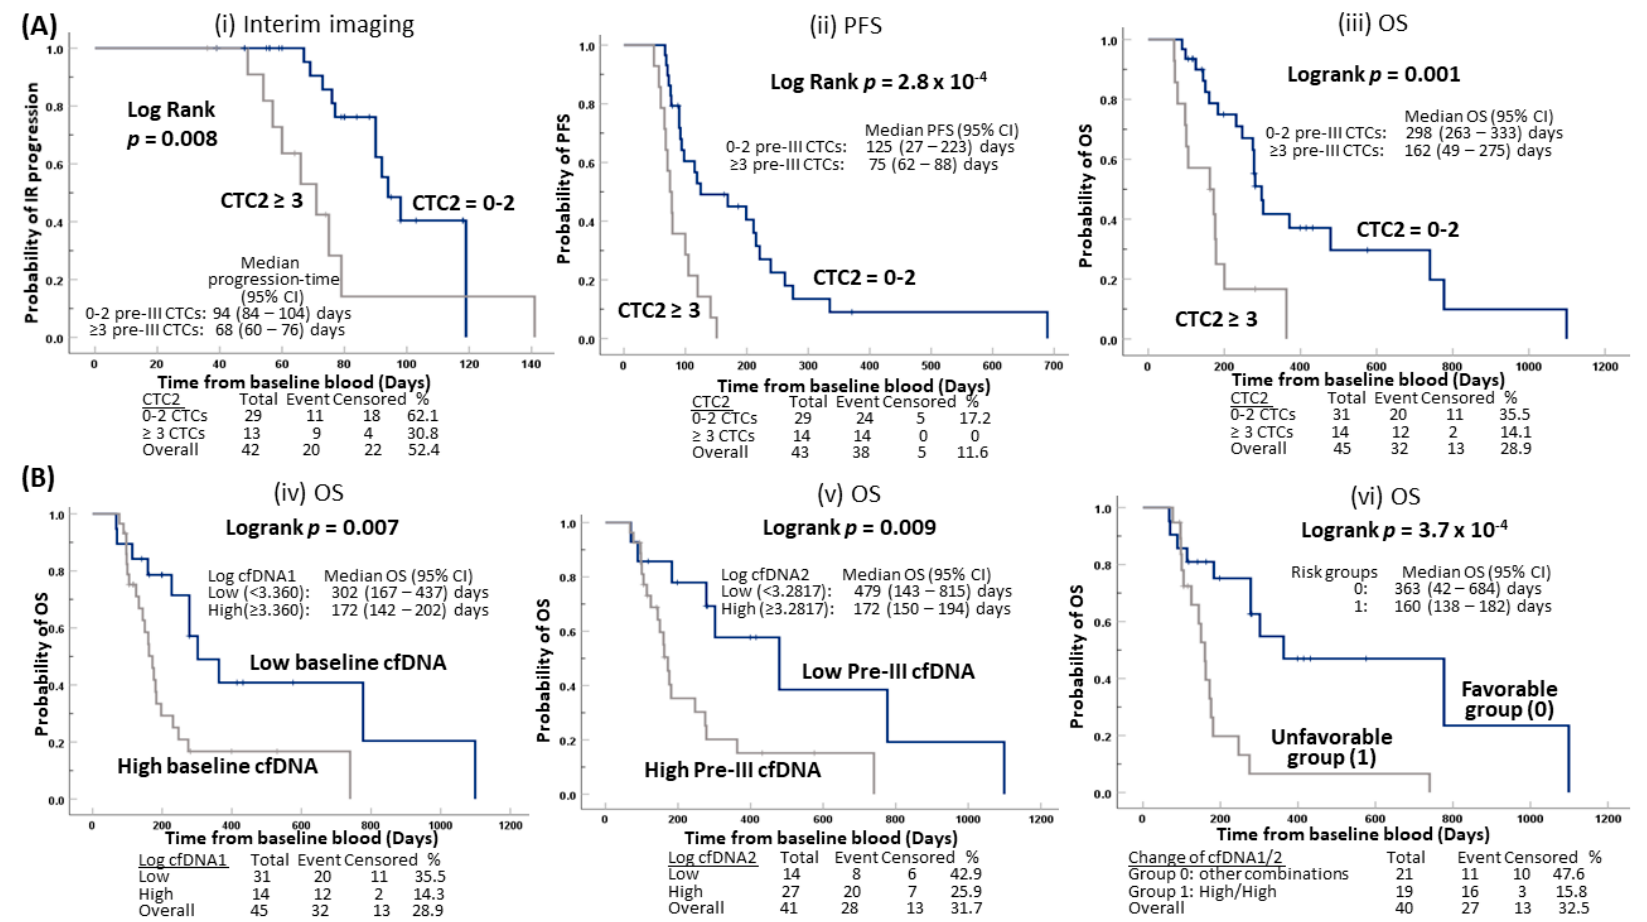
Figure 2. Kaplan-Meier survival analysis of (A) CTC enumeration at the end of two cycles of CT and (B) cfDNA at baseline, end of two cycles of CT, or their unfavorable change in advanced or refractory ESCC patients.